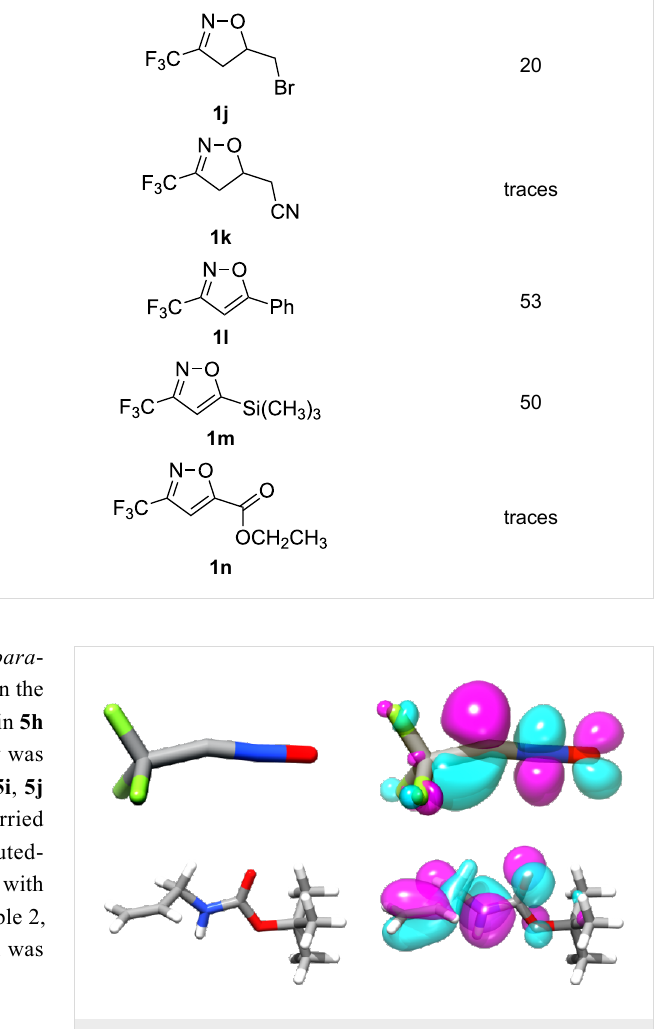
Figure 4: Depiction of the geometry (left column) and isodensity surface of the reacting frontier molecular orbitals (FMO) at 50% proba- bility (right column) of trifluoroacetonitrile oxide 4 (top row) and protected aminoalkene 5c (bottom row) calculated at the B3LYP/6- 31G*